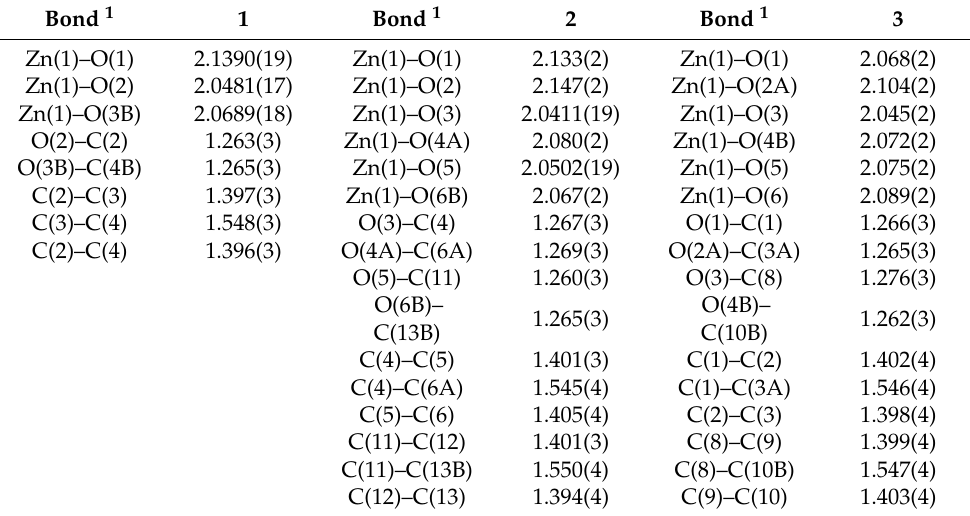
Figure 5. The view of molecular structure of the crystallographic unit in 3 . Photo of crystals is in the inset. Table 2. Selected bond lengths (Å) in 1 – 3 .